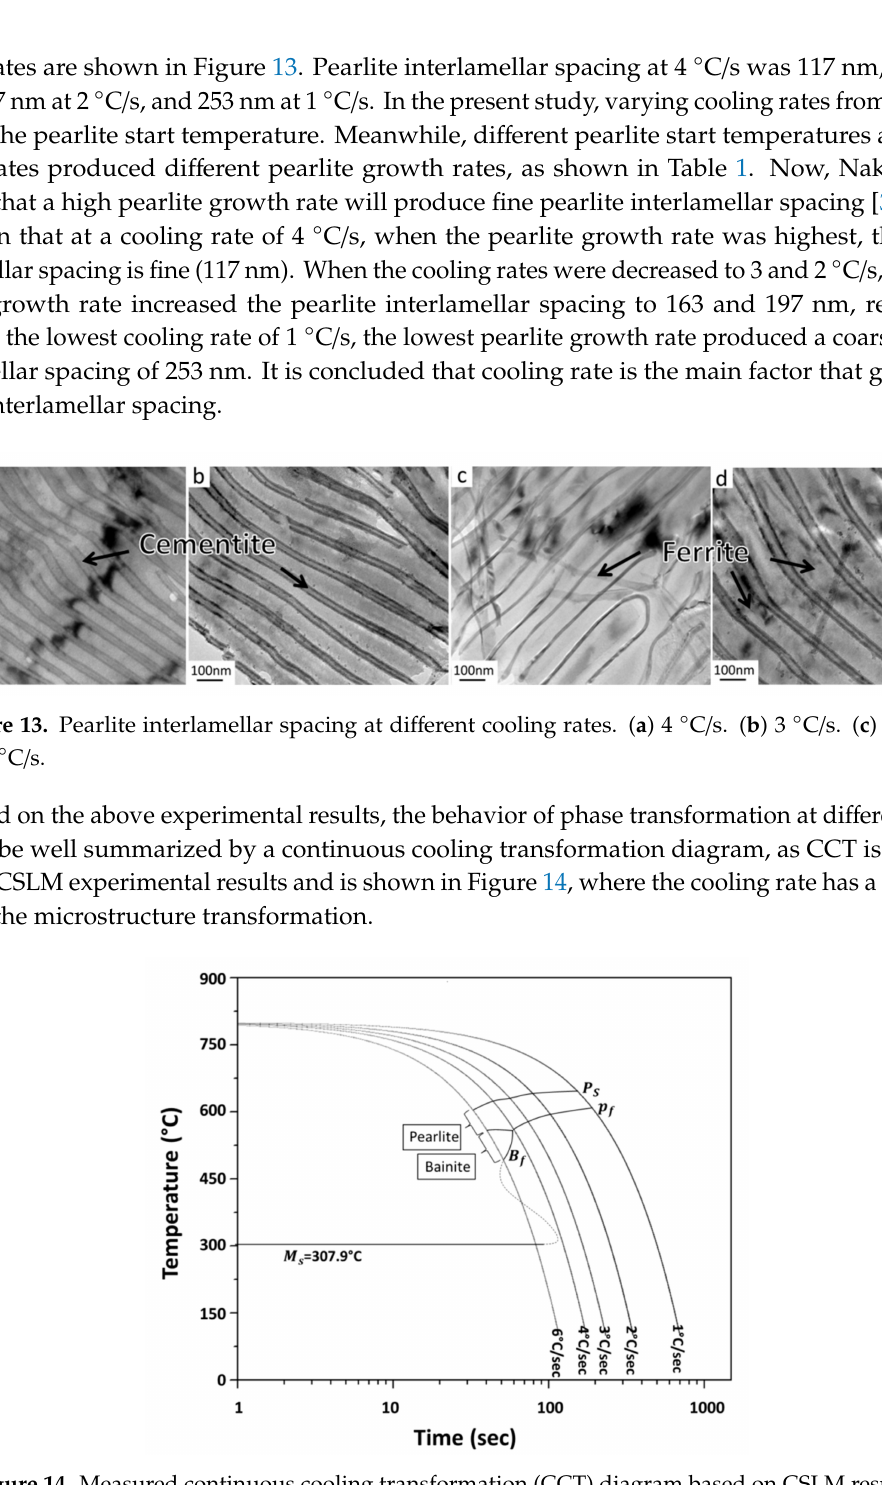
Figure 14. Measured continuous cooling transformation (CCT) diagram based on CSLM